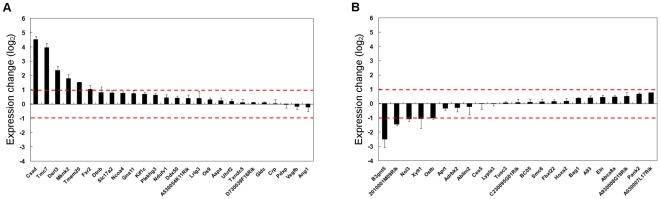
Expression Modulation of Genes with Promoters Hyper- and Hypo-acetylated at H3K9.Hyper-acetylated genes (A) and Hypo-acetylated genes (B) were pre-selected by ChIP on chip data and validated by ChIP-qPCR for alterations in H3K9Ac, and then analyzed for changes in gene expression by qRT-PCR (n = 2). Bars are shown as the average of duplicate assay results for changes in expression levels in C1 relative to D1. Standard deviations are shown using error bars. Upper red dotted lines represent 2-fold increase and lower red dotted lines represent 2-fold decrease.